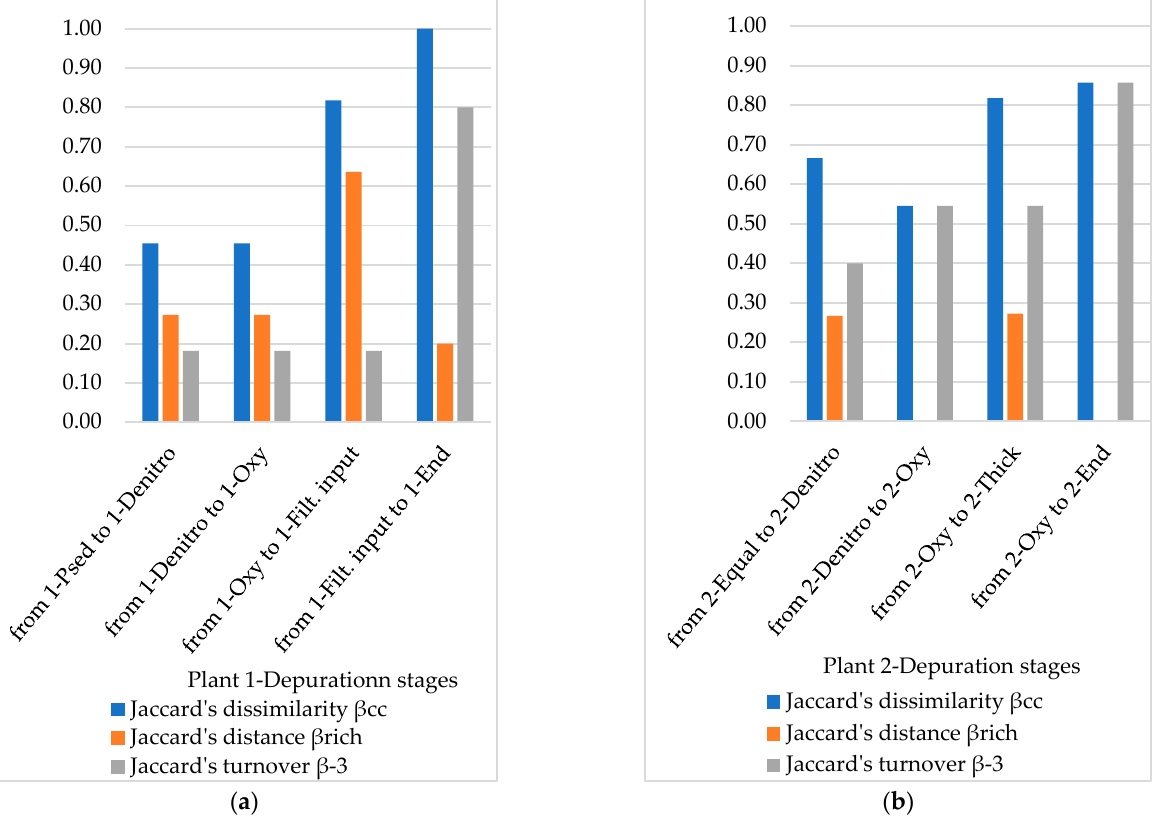
Figure 7. Pairwise distance and directional turnover based on Jaccard’s models at a genus scale in different depuration stages in Plant 1 ( a ) and Plant 2 ( b ).